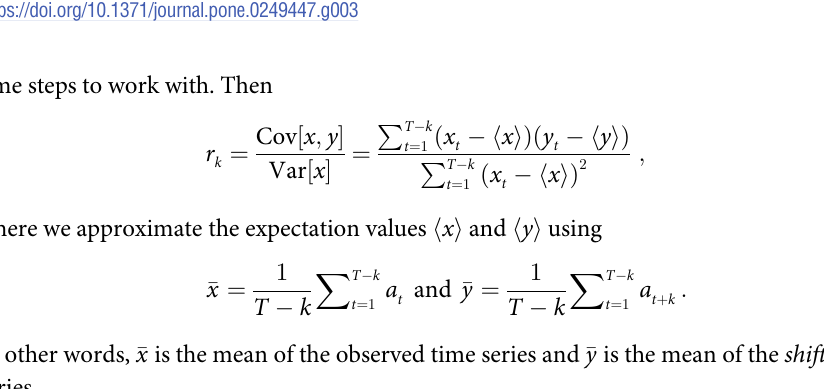
on a logarithmic scale) are invariant. k